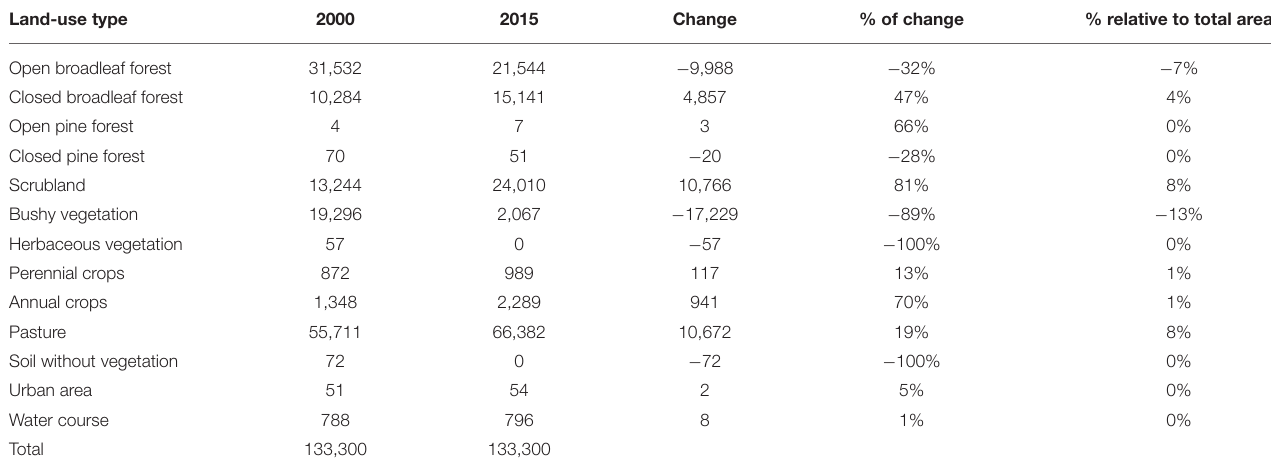
TABLE 4 | Land-use change (ha) between 2000 and 2015 in the municipality of Waslala, Nicaragua. Land-use